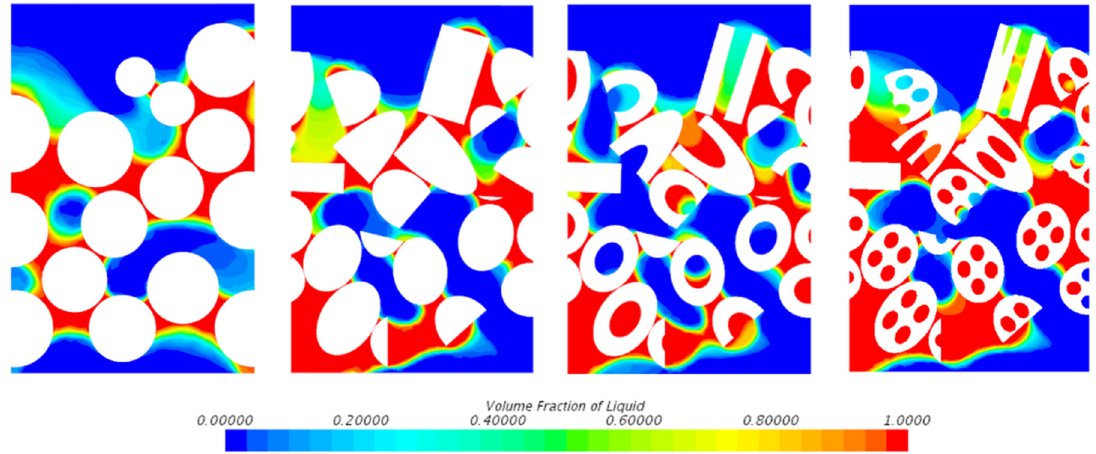
Figure 4. Liquid distributions inside four packing structures ( v G = 0.245 m/s, v L = 0.008 m/s).